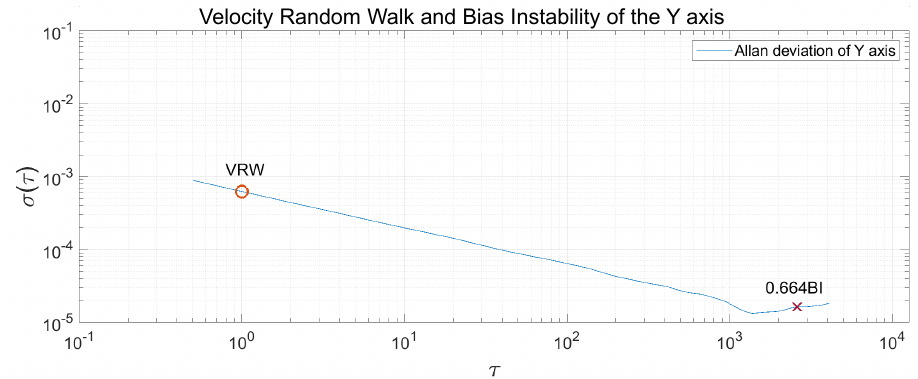
Figure 13. Velocity random walk and bias instability of the sensor x -axis.